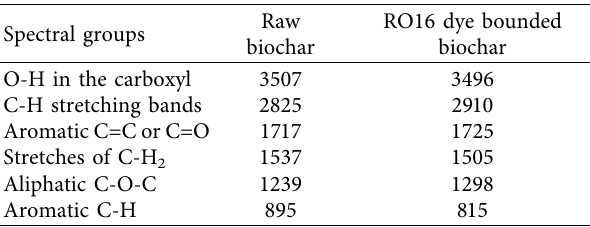
Table 2: FT-IR spectra (before and after sorption).